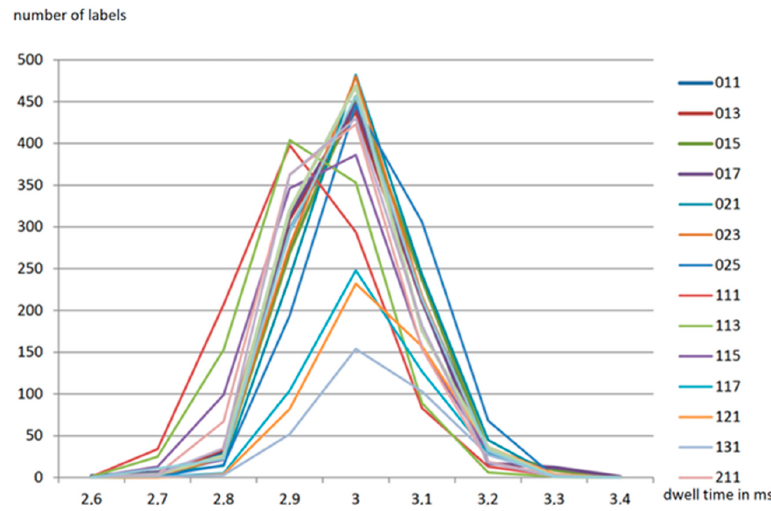
Figure 15. 4-Channel Measurement for the flap load relief function.